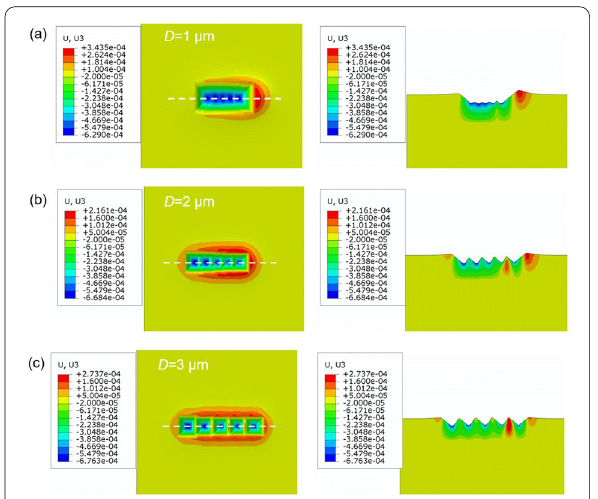
Figure 9 Top views and the corresponding cross-sections of the simulated results for the one array indentations with the rotation angle of 45° and the spacings of a 1 μm, b 2 μm and c 3 μm